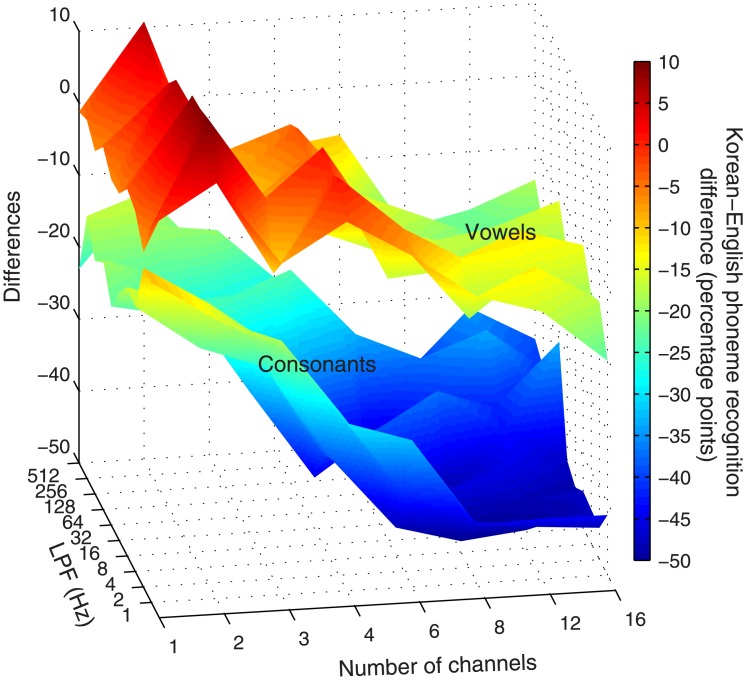
Differences in Korean and English phoneme recognition scores.The original percent-correct scores of Korean phoneme recognition scores were taken from Figs 1 and 2 of the present study whereas the original percent-correct scores of English phoneme recognition scores were taken from the Xu et al. (2005) study. Those original percent-correct scores were converted to chance-corrected scores first using the formula: Pcorrected = (Po−Pc)/(1 –Pc), where Po is the original percent-correct score and Pc is the chance performance. The surface plots show the differences (Korean Pcorrected−English Pcorrected) for consonants and vowels as a function of the number of channels and the lowpass cutoff frequency (LPF).